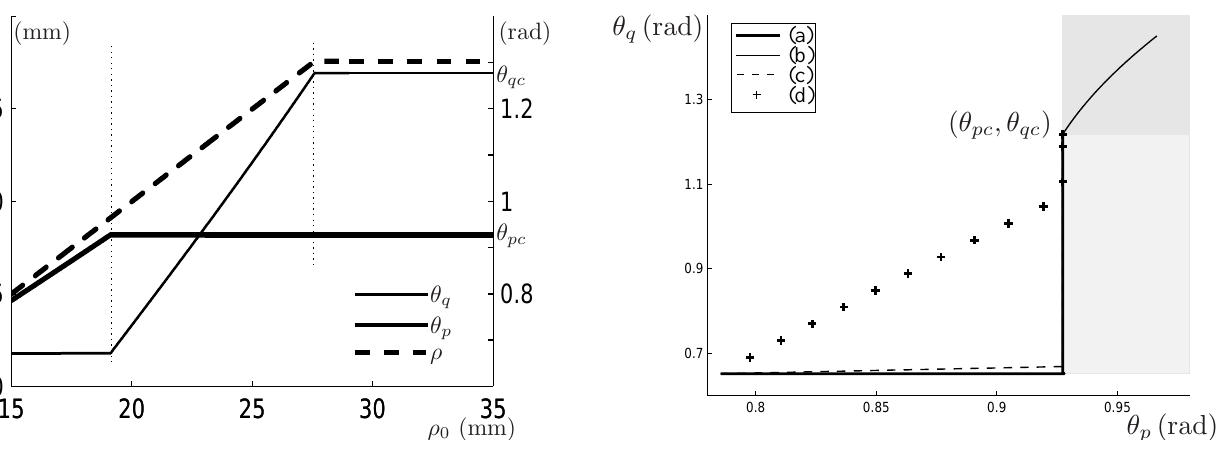
(cid:16) (cid:17) θ p ,θ q and the ac-